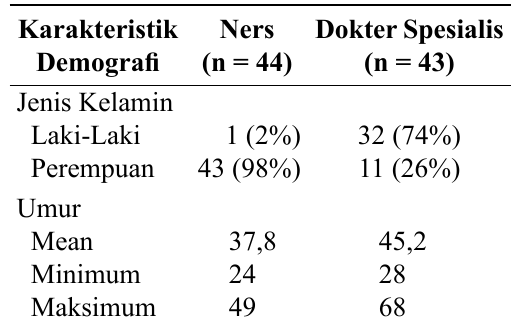
Tabel 1. Karakteristik demogra fi responden